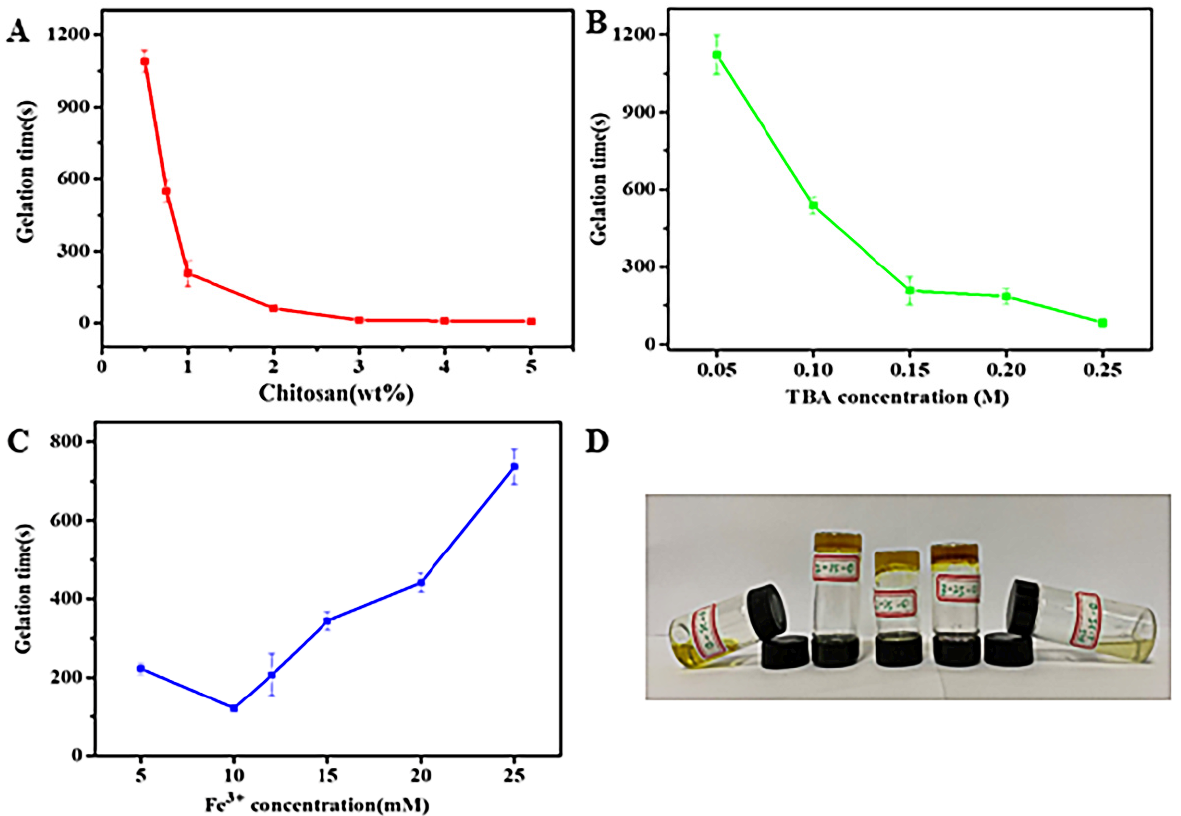
Figure 3. Gelation time of CS-TBA-Fe hydrogels varies with concentration of chitosan ( A ), TBA ( B ), and Fe 3+ ( C ), and the photos of the mixtures of chitosan and TBA without Fe 3+ ( D ). Table 1. Gelation time of CS-TBA hydrogels with different formula.